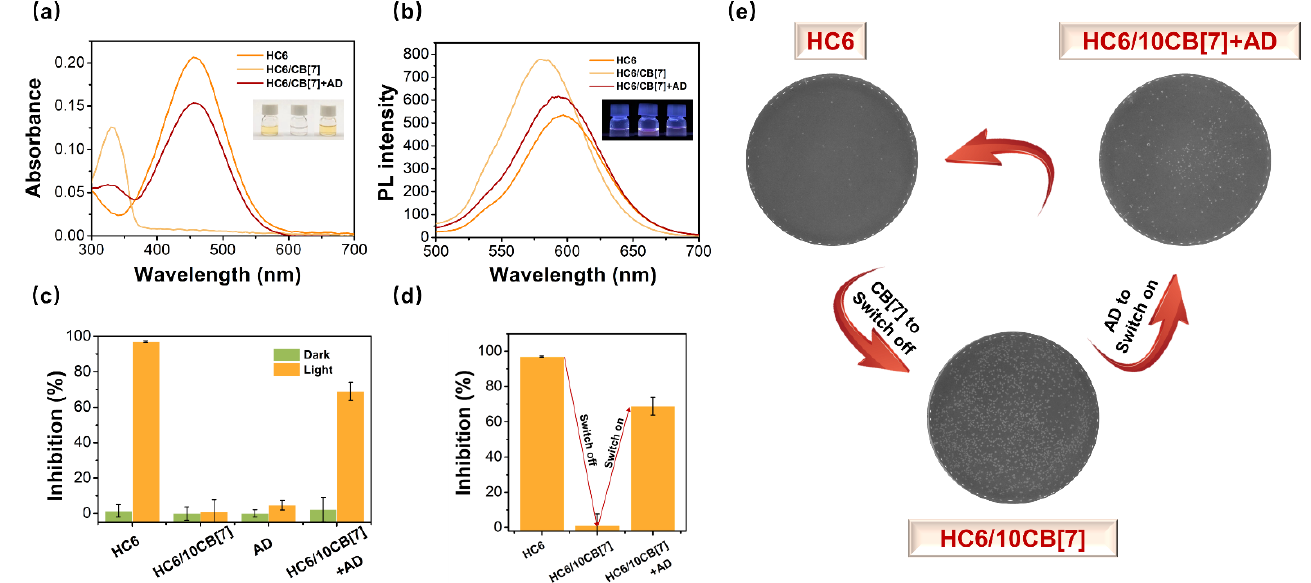
Figure 6. ( a ) UV-vis absorption spectra and ( b ) fluorescence emission spectra of HC6 assembly or dis-assembly using CB[7] or AD. ( c ) Inhibition rates of “antimicrobial switch” and AD on E. coli under dark and light conditions. ( d ) Histogram of “antimicrobial switch” regulating the photodynamic antimicrobial ability of HC6 against E. coli after irradiation with white light (65 mW/cm 2 ) for 10 min. ( e ) Agar plate diagrams of “antimicrobial switch”, HC6: CB[7]:AD = 1:10:50.